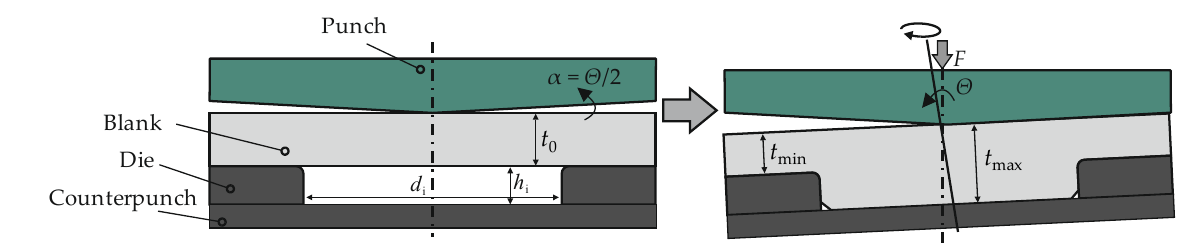
Figure 1. Schematic process setup of orbital forming with circumferential die.